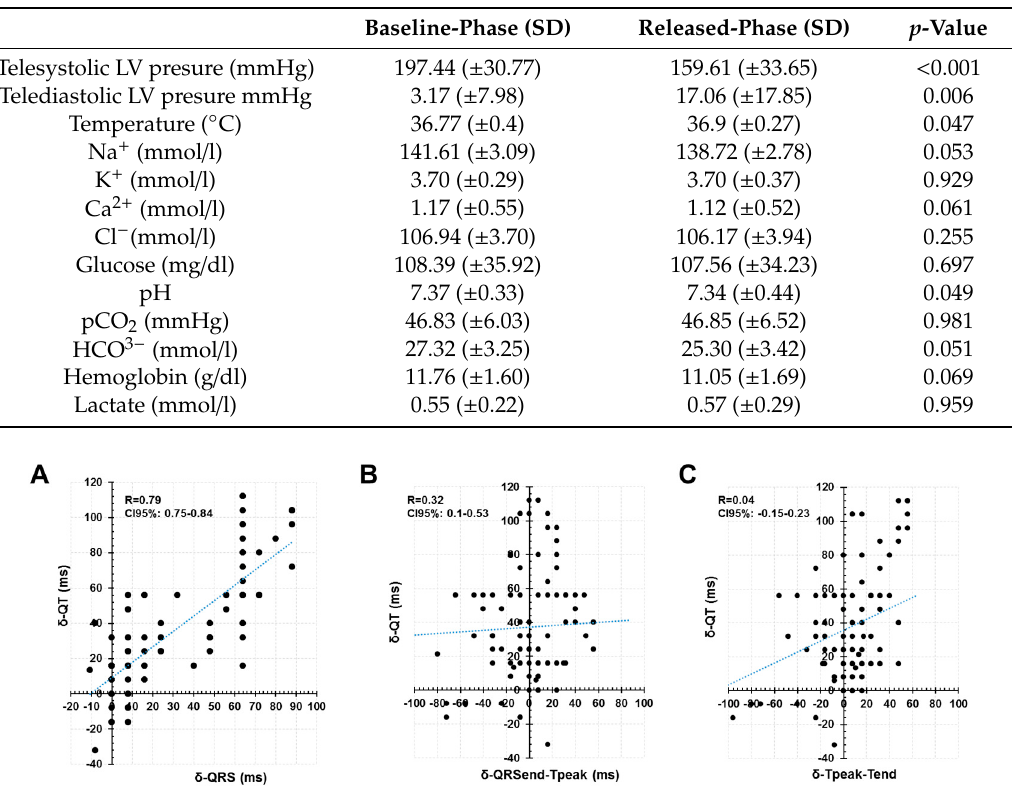
Table 3. Univariate analysis of confounding factors.